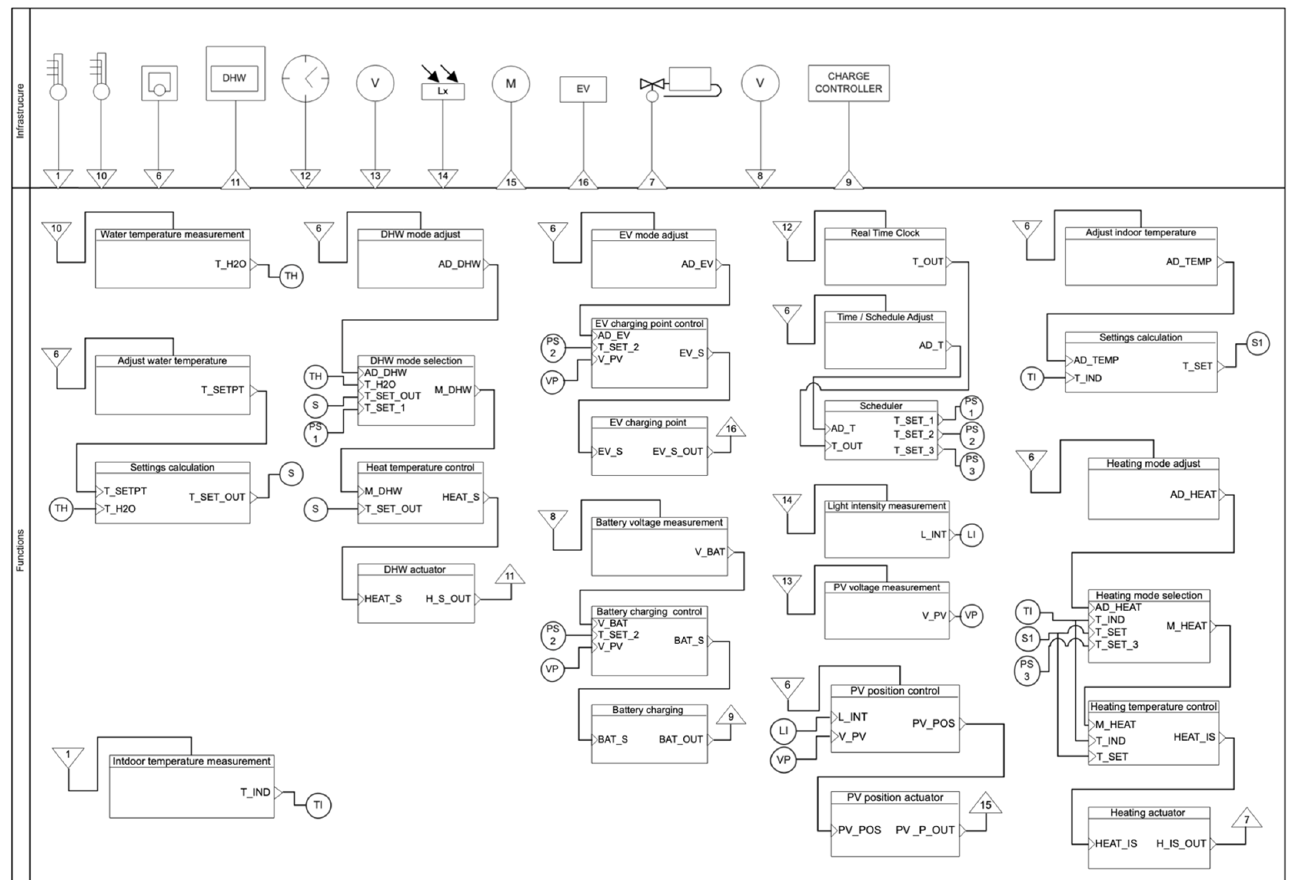
Figure 1. A functional diagram of control and energy management system for small prosumer installation organized according to the EN 15232 standard BACS efficiency class C with additional functions proposed in the paper.